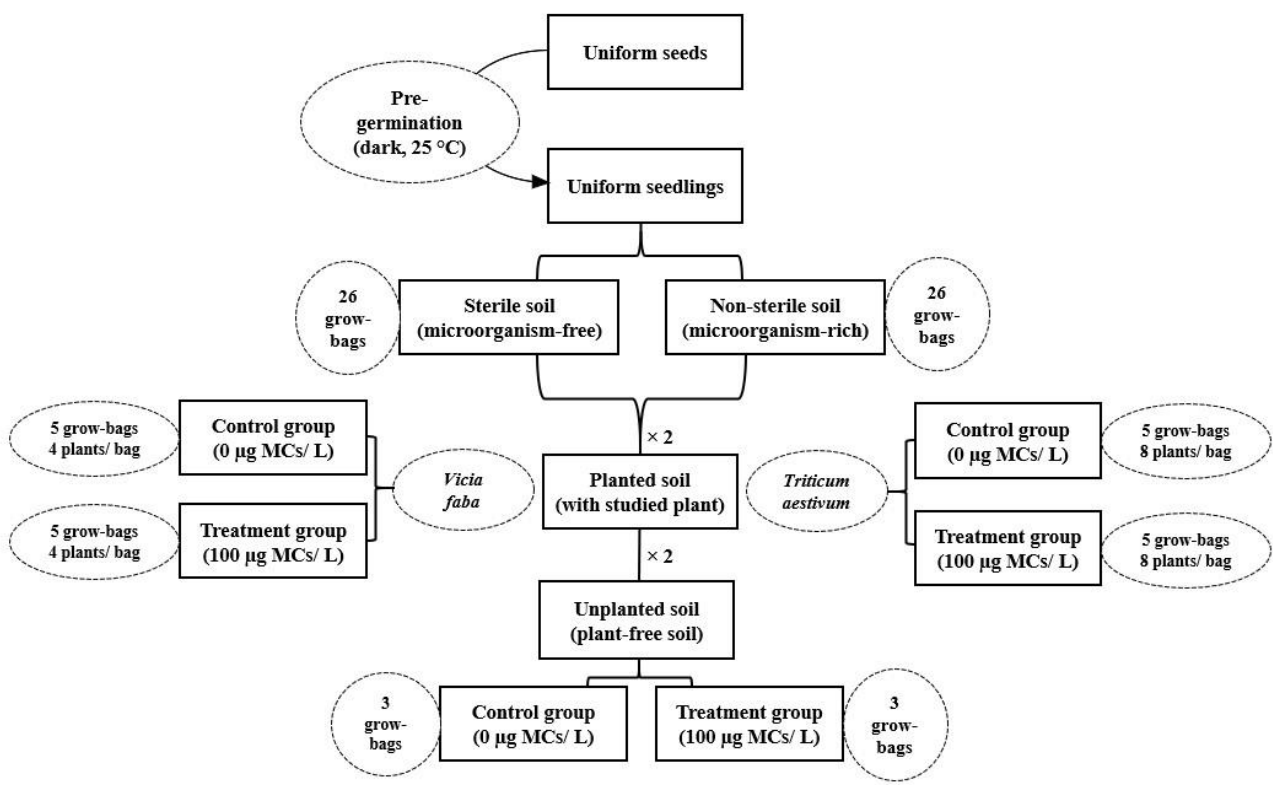
Figure 1. Experimental setup chart ( × 2): The design chart for planted and unplanted soils is the same either in sterile or non-sterile soils for each of the studied species.